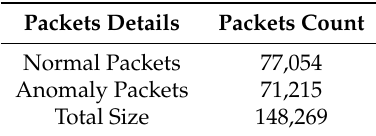
Table 4. NSLKDD dataset binary classifications total packets.